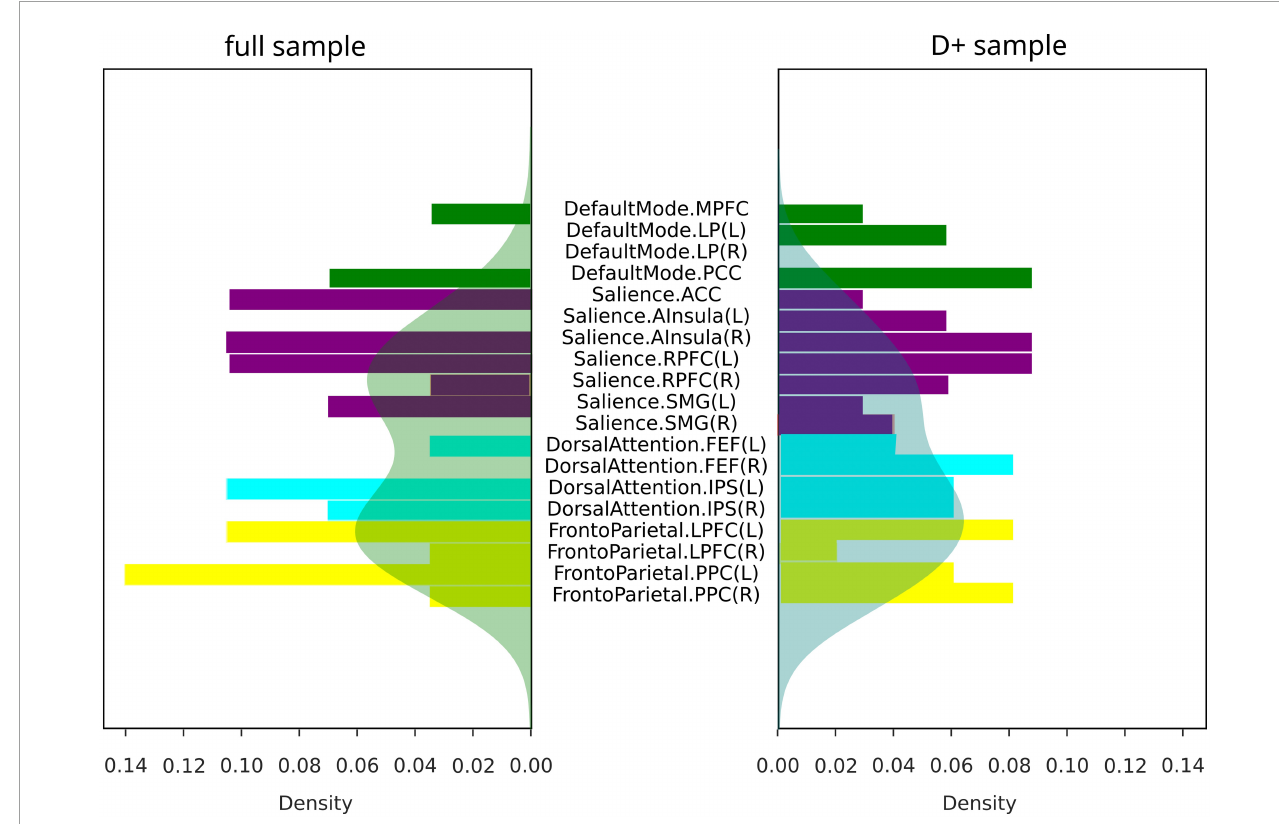
FIGURE6 Covariance differences across modalities in all subjects (full sample for V/NV comparison, and D+ sample for V D + /NV D + comparison). Colors represent networks: DMN–green, SN–purple, DAN–cyan, FPN–yellow. Shaded areas represented density functions of the histograms and highlighted differences in frequency of node